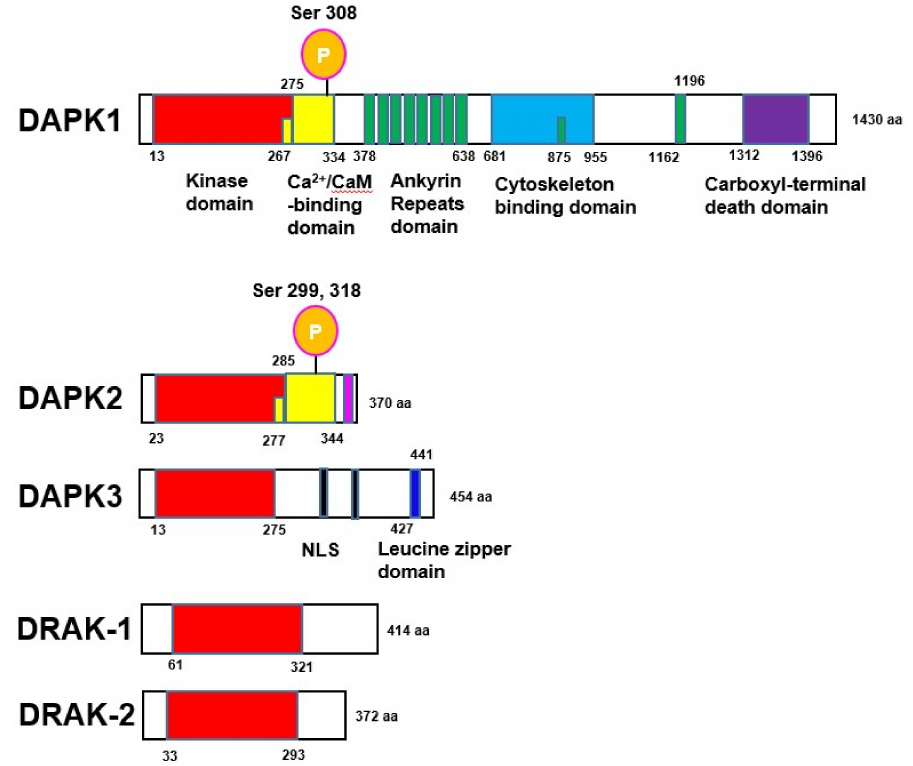
Figure 1. Structures of death associated protein kinase (DAPK) family proteins. DAPK1 possesses an N-terminal kinase domain, a Ca 2+ /Calmodulin (CaM)-binding domain, an ankyrin repeats domain, a cytoskeleton binding domain, and a carboxyl-terminal death domain. DAPK1 is auto-phosphorylated at Ser308, which blocks its CaM binding site and keeps the site inactivated. DAPK2 contains an N-terminal kinase domain, a Ca 2+ /CaM-binding domain, and a C-terminal tail with no homology to any known proteins. DAPK2 at Ser318 is dephosphorylated and promotes CaM binding to the autoregulatory domain. Phosphorylation of DAPK2 at Ser299 increases DAPK2 activity independently of CaM binding. DAPK3 has an N-terminal kinase domain, a leucine zipper domain, and two nuclear localization sequences (NLS). DRAK-1 and DRAK-2 have an N-terminal kinase domain. The location and total number of amino acids (aa) are shown. The recent domain information on human DAPK family proteins was collected from